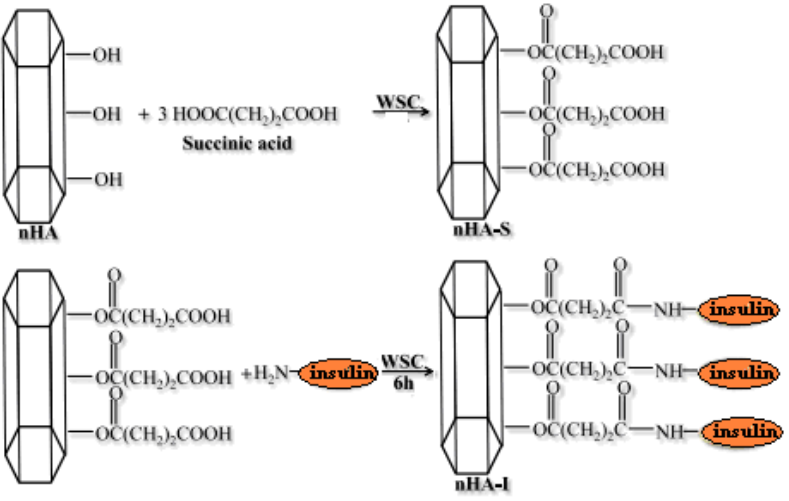
Figure 16. Schematic diagram depicting the grafting of insulin at the surface of nHA [70].